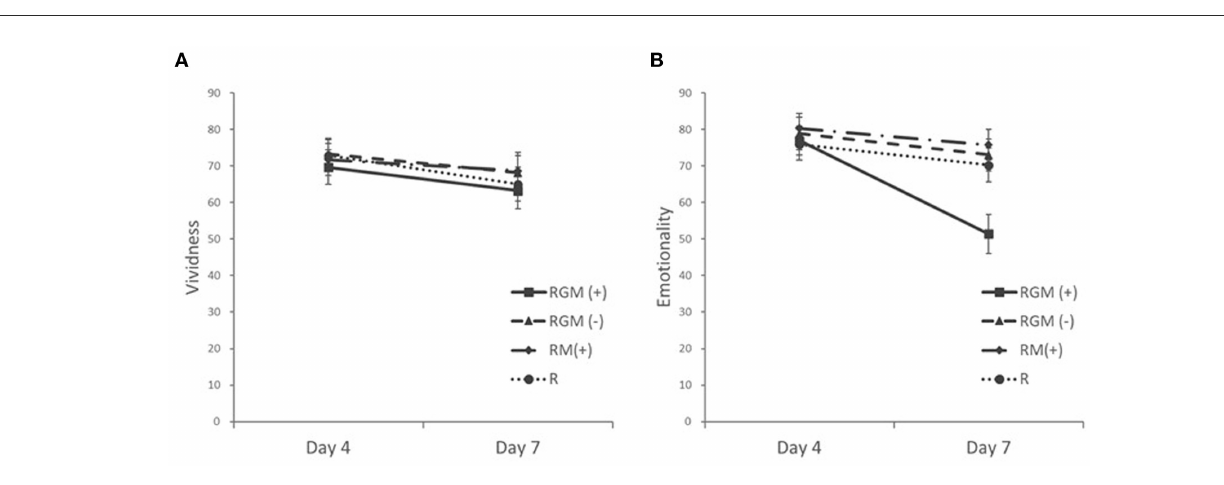
plus background music in the group RGM ( + ) is due to the simple summation effect of two methods. As expected, the RGM ( + ) group had the highest ratings in concentration, enjoyment and addiction among the groups. These accorded with the feature of the so-called